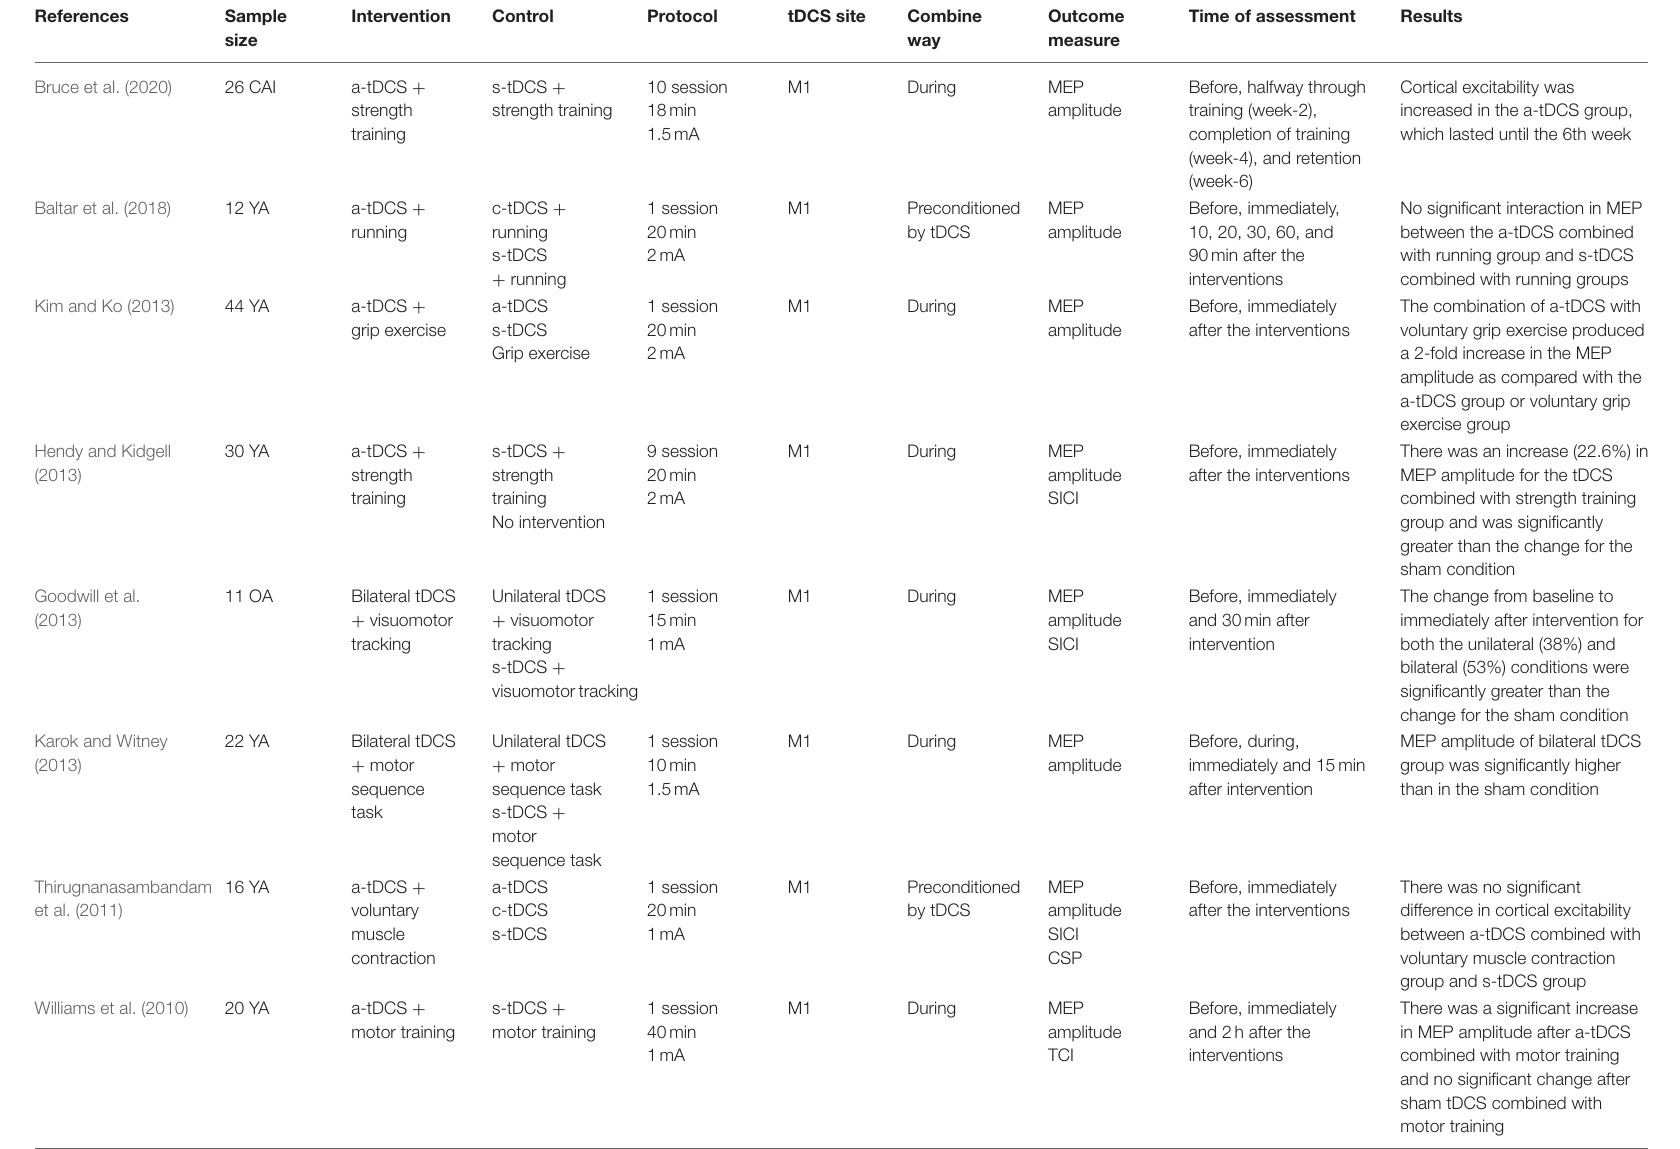
TABLE 1 | The effects of tDCS combined with physical training on the excitability of the motor